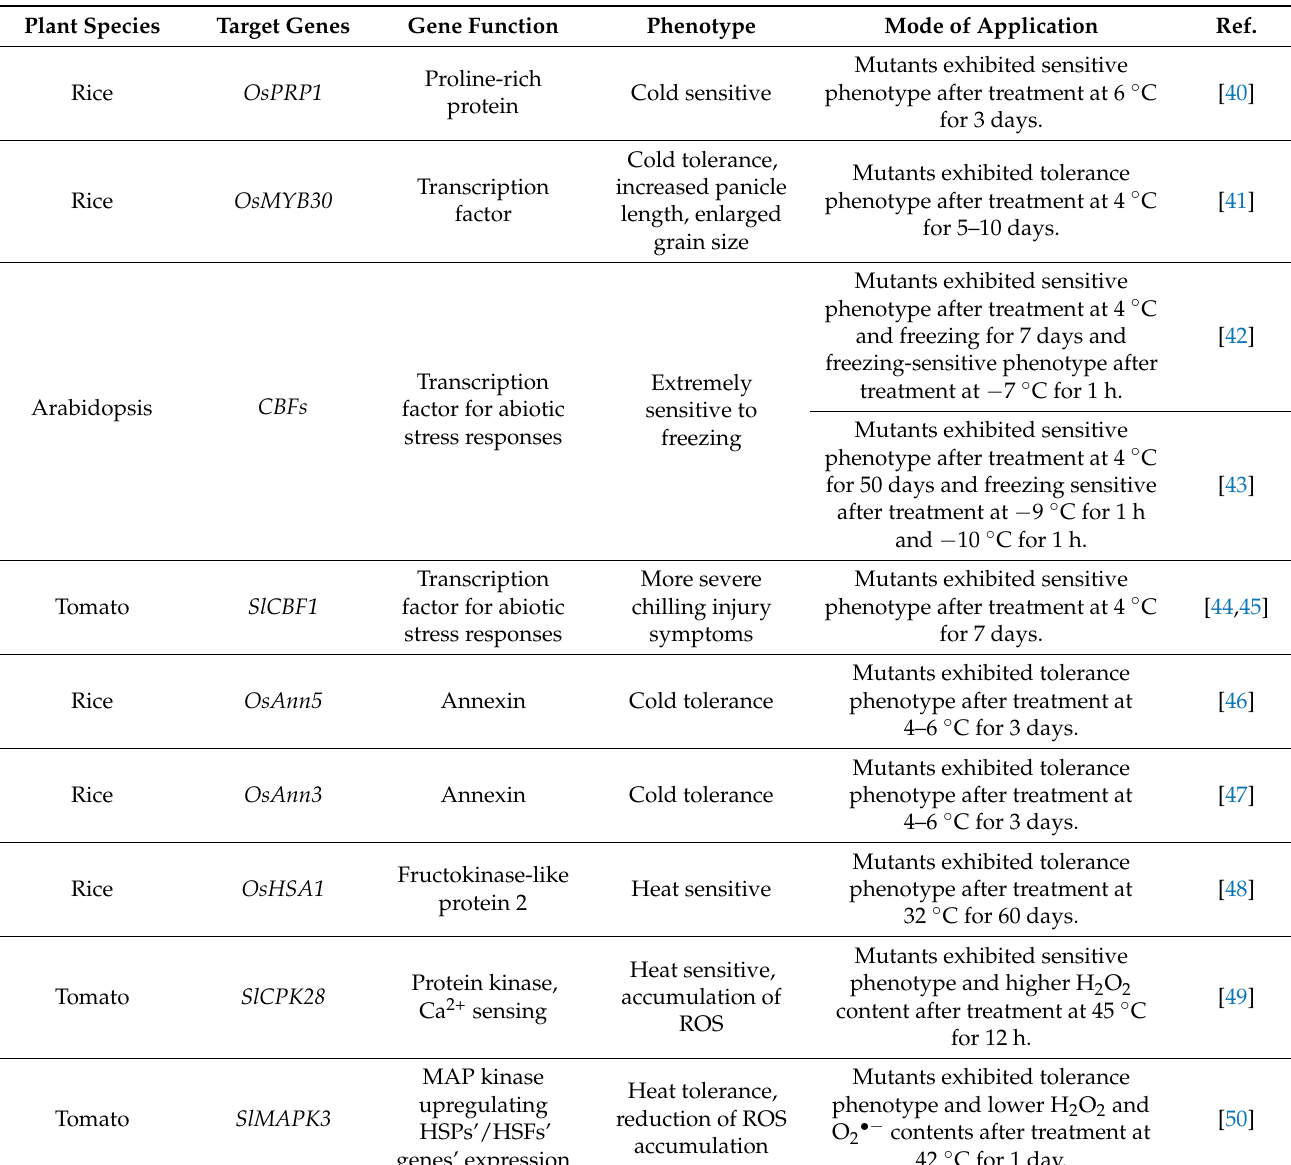
Table 1. Application of CRISPR/Cas9-mediated genome editing to elucidate genes involved in response to temperature, drought, and salinity